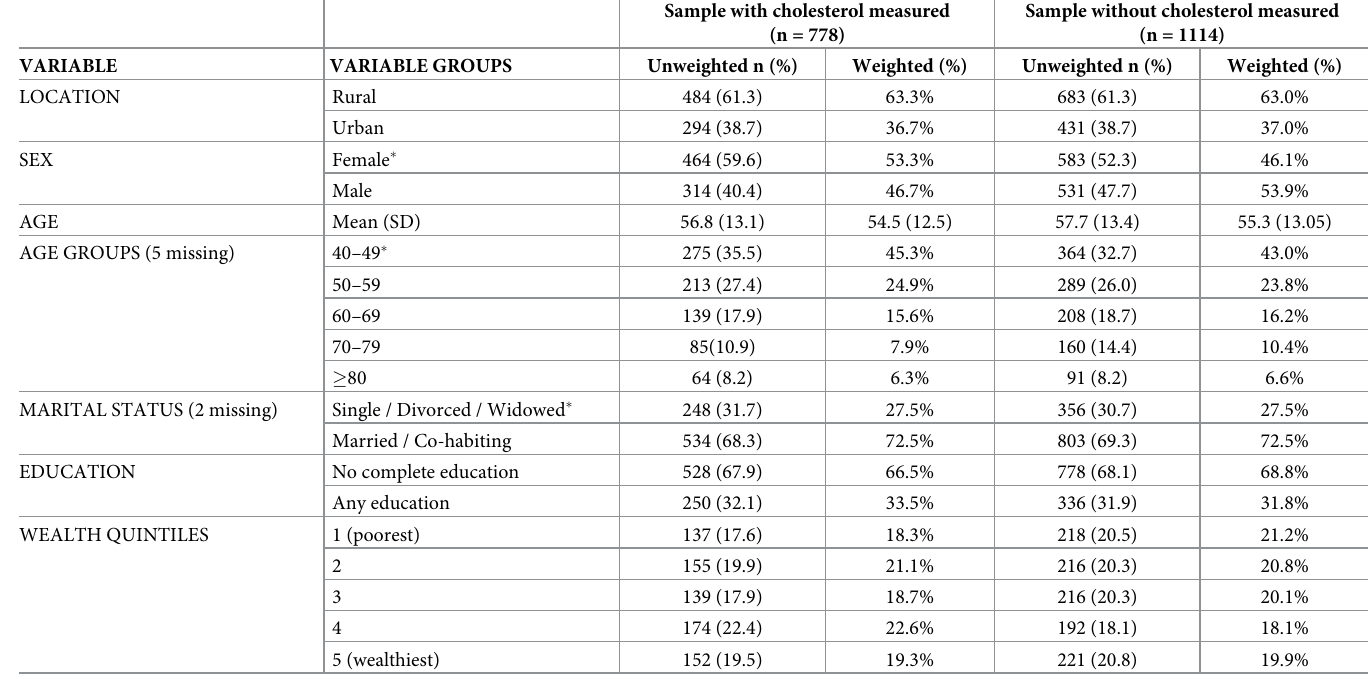
Table 1. Unweighted and weighted demographic characteristics of the study sample in the sample with and without measured cholesterol.